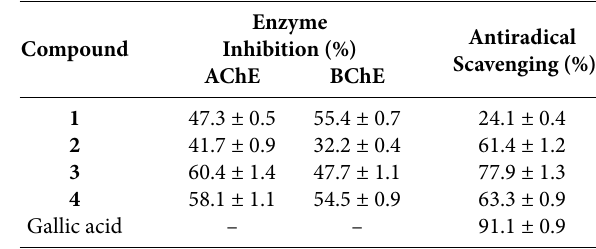
Table 3. Antimicrobial potential of synthesized esters 1 – 4